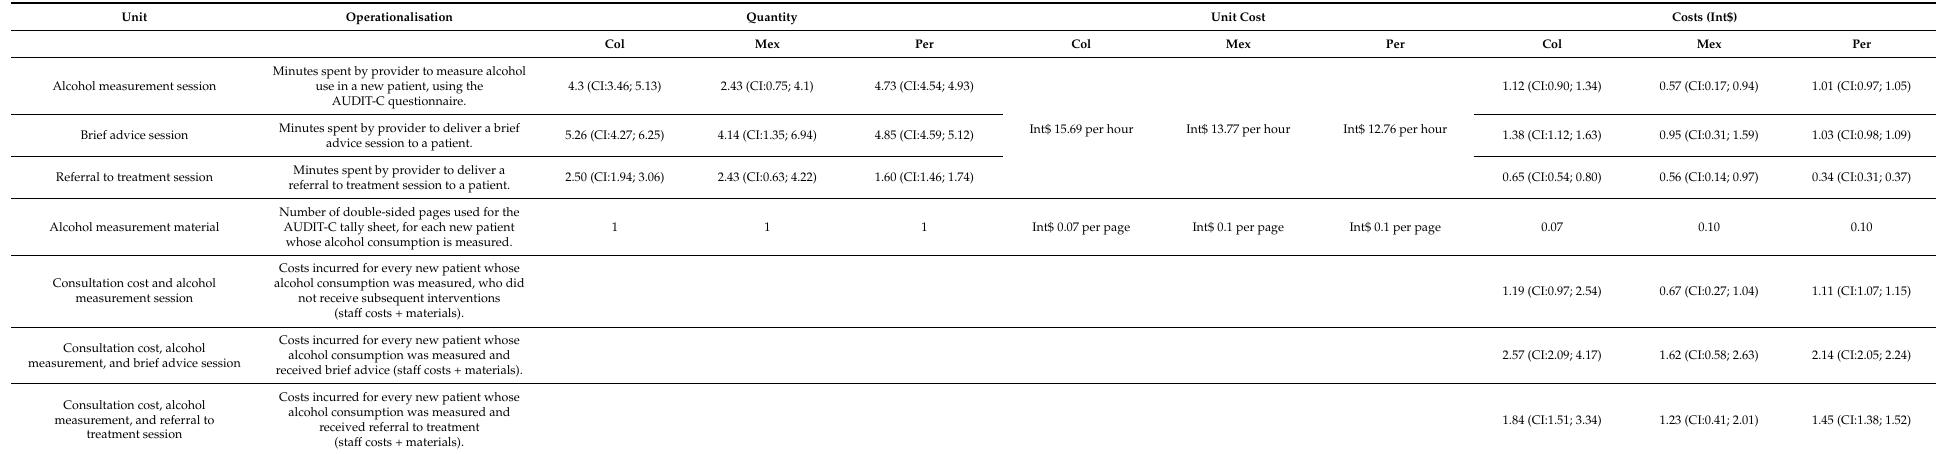
Table 1. Costs units, quantities, and prices of brief alcohol advice